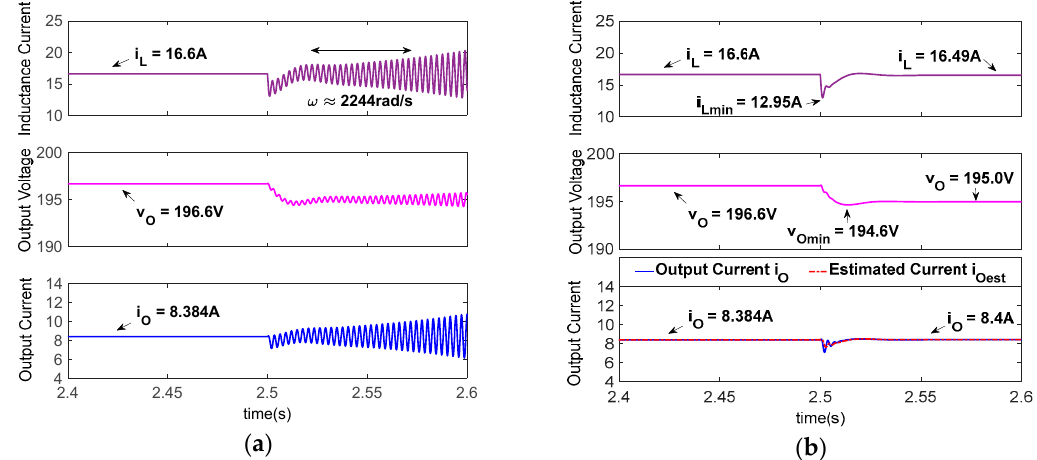
Figure 17. Comparative simulation results of the studied dc microgrid system with the droop coefficient variations. ( a ) Conventional droop controlled system; ( b ) Proposed NDOB-VNI stabilizing strategy controlled system.